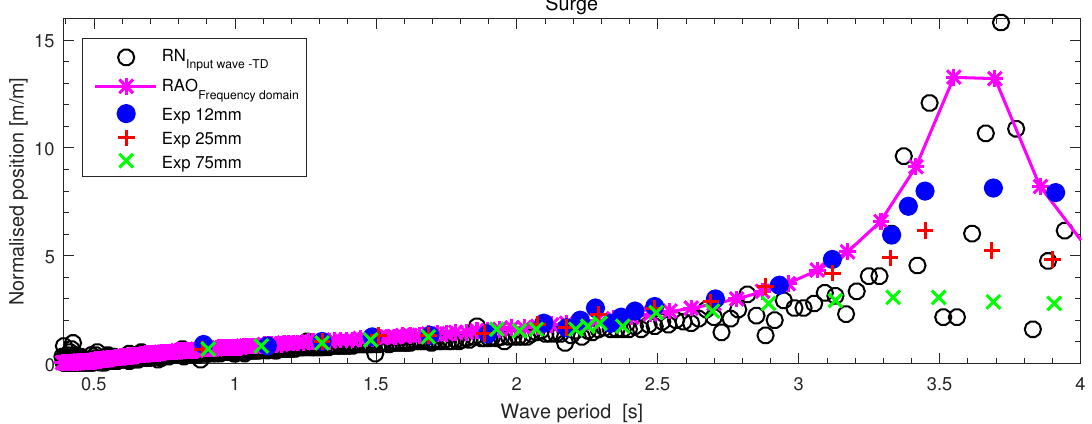
Figure 11. Surge RAO (fromthe frequency domain) alongside the normalised response from time domain results of the panchromatic waves ( RN input wave − TD ). Experimental measurements for the regular waves of amplitude 12 mm, 25 mm, and 75 mm are also